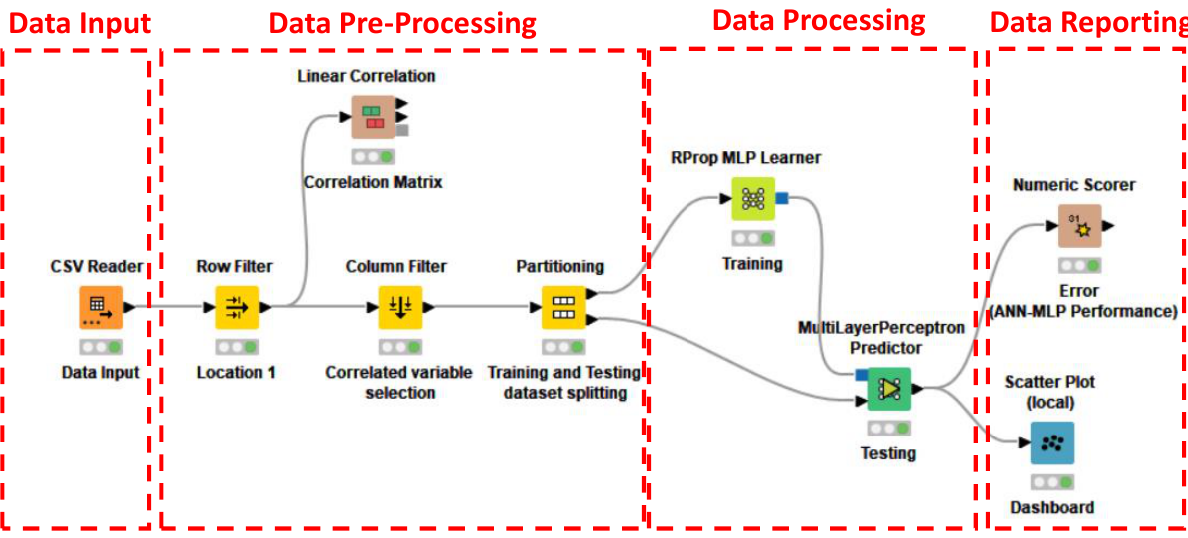
Figure 5. KNIME workflow implementing ANN-MLP network predicting important variables about worker security (in the analyzed case is predicted the labelled variable smoke ).